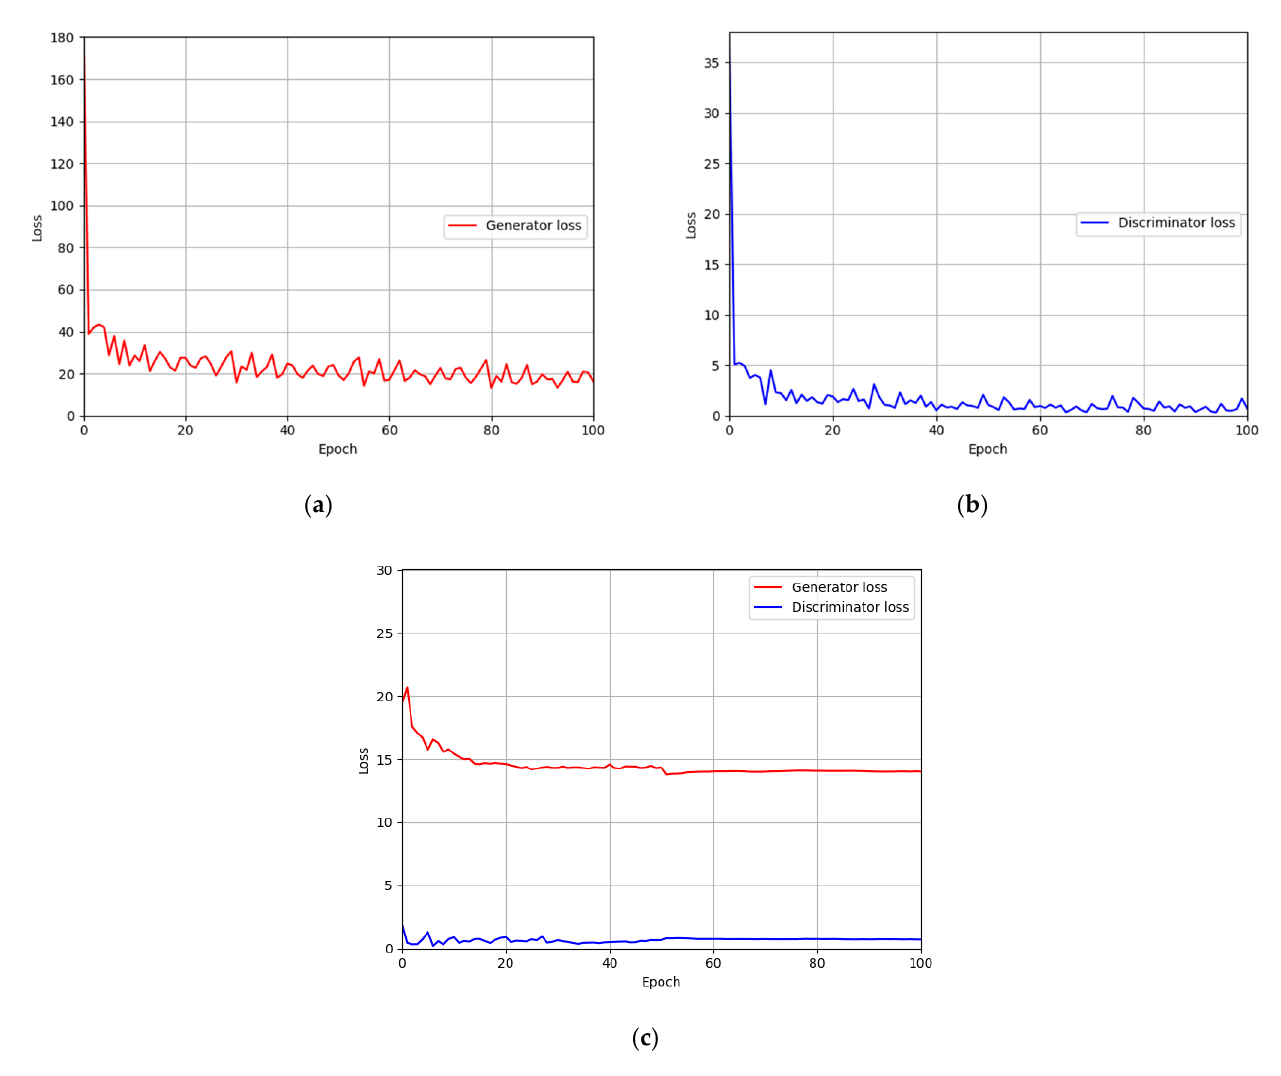
Figure 12. Training and validation loss graphs of the modified DeblurGAN (PolyU-DB): training loss graphs of ( a ) generator and ( b ) discriminator. ( c ) Validation loss graphs of generator and discriminator.